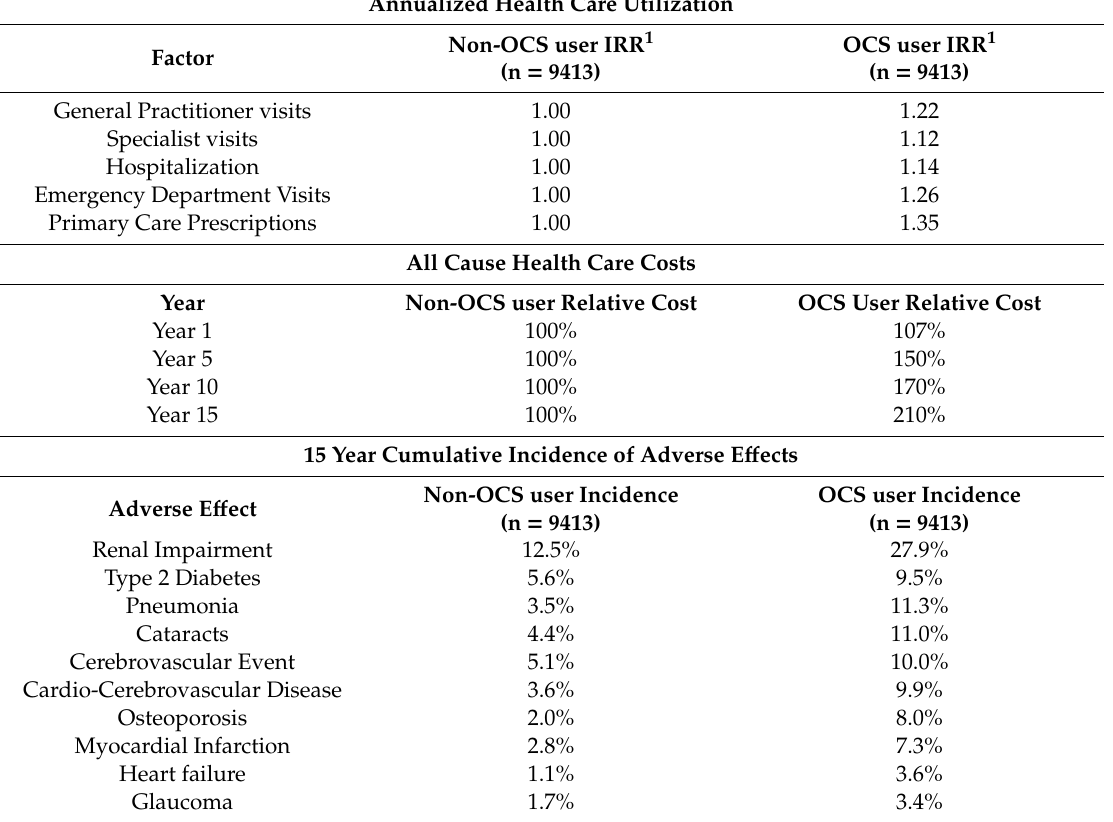
Table 1. Healthcare resource utilization and costs associated with oral corticosteroid (OCS) use in a matched historical cohort extracted from the UK Clinical Practice Research Datalink Database from 1994 to